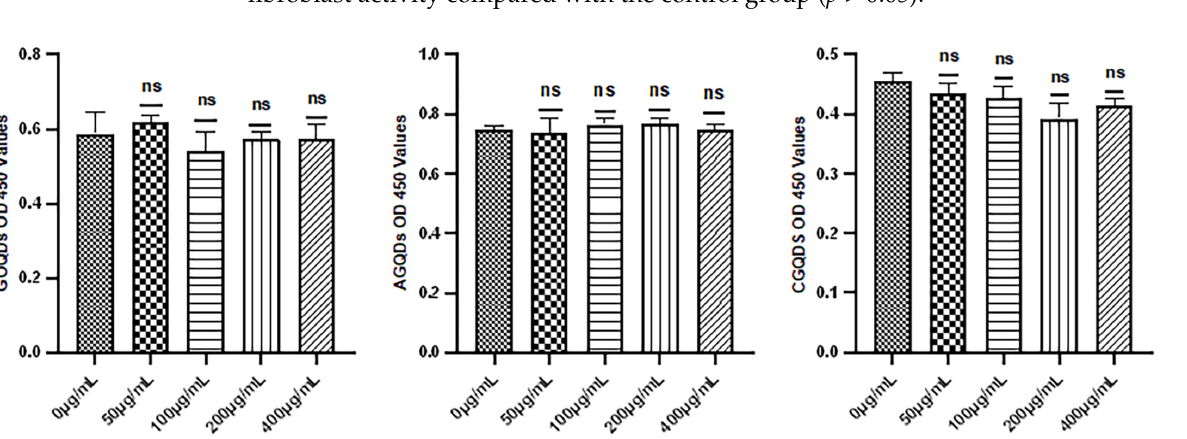
Figure 3. The CCK8 test results of Graphene Quantum Dots. ns: p > 0.05.